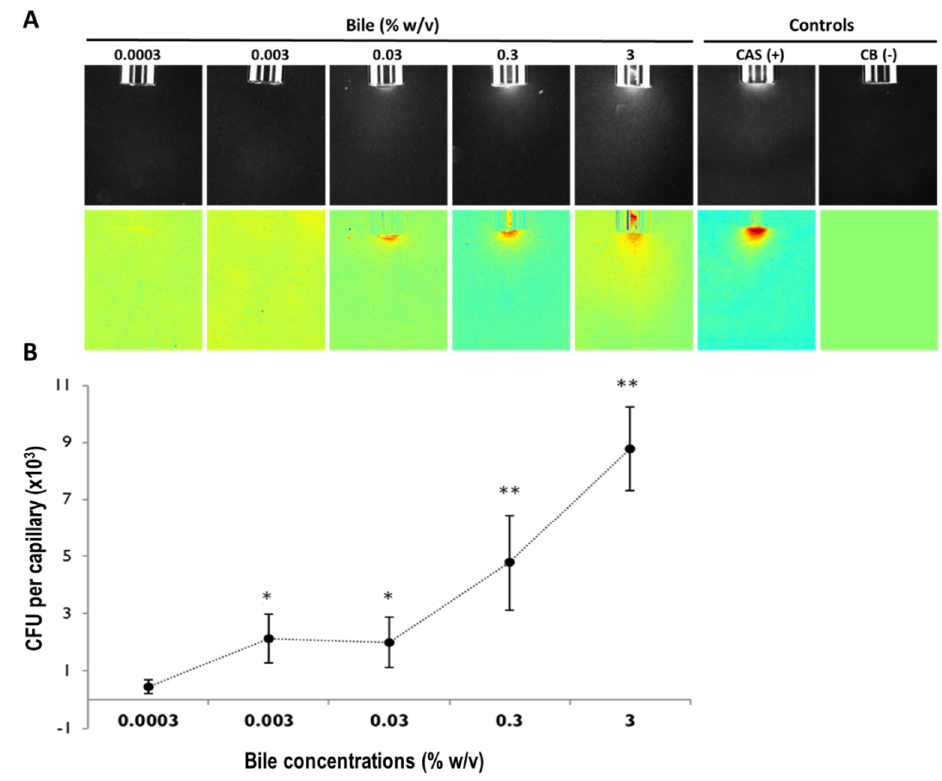
Figure 2. Chemotaxis of P. aeruginosa PAO1 toward bovine bile in the absence of cystic fibrosis -derived bronchial epithelial (CFBE) cells using qualitative ( A ) and quantitative ( B ) microcapillary assays. ( A ) PAO1 chemoattraction towards bile (0.0003–3% w/v ). Top panel: Dark-field images of bacterial cells gathered at the mouth of microcapillaries containing attractants at time 5 min. Below panel: Color map “jet” (MATLAB R2013b version 8.2; www.Mathworks.com, accessed on 5 September 2013) representing a normalization with the time 0 min for each treatment. The positive control (casamino acids, (0.2%, w/v ) (CAS)) and the negative control (chemotaxis buffer (CB)) are shown for contrast. ( B ) Quantitative assay illustrating the concentration-response curve of P. aeruginosa PAO1 to bovine bile (0.0003–0.3% w/v ) diluted in chemotaxis buffer. Results are averaged of at least 18 capillaries from 7 independent experiments. The results have been normalized with S2). Error bars indicate standard error. A comparison between the five concentrations of bile tested